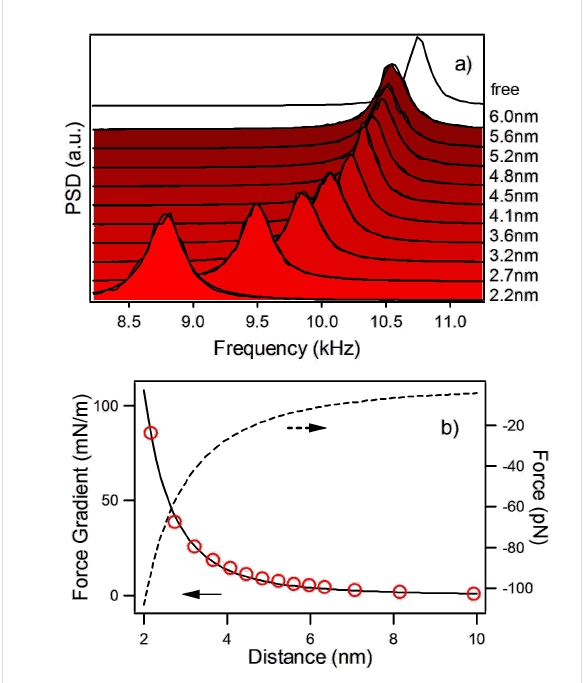
Figure 2: Results from the Fourier transform method, adapted from [9]. a) Power spectral density of the thermal fluctuations of the first flexural mode of the cantilever acquired at different tip-sample separa- tions. A negative frequency shift of the resonant frequency is observed on approaching the graphite surface. The resonance peaks are fitted with a Lorentzian. b) The black continuous line is a fit of the van der Waals force gradient between a spherical tip and a flat surface (force gradient = HR /3 z 3 , z is the tip-sample distance) to the measured fre- quency shift of the first flexural mode as a function of the tip-surface separation (red circles). The dashed line is the interaction force obtained by